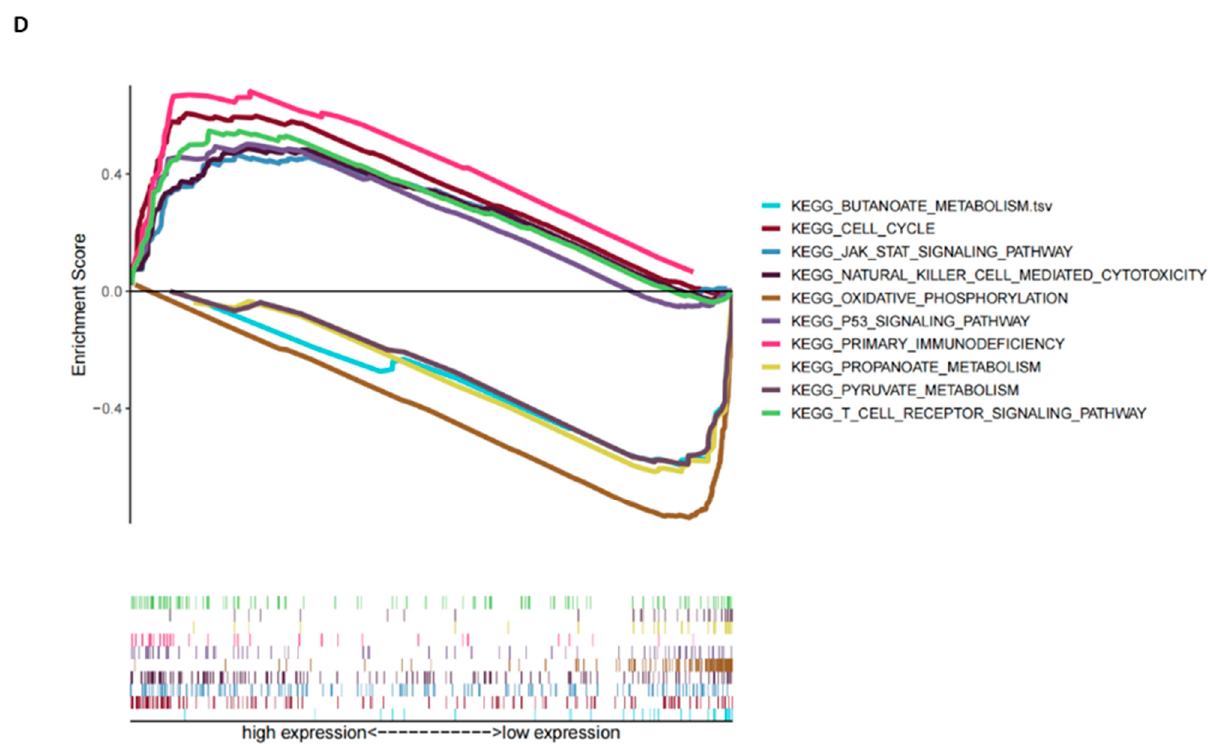
Figure 6. The correlation of the TIC composition and signaling pathway with EZH2 expression. ( A ) Correlation of the TIC population with EZH2 expression, the Violin diagram shows the relationship between the different 22 TIC subpopulations and the KIRC tumor samples with low (green) or high (red) EZH2 expression, relative to the median of the EZH2 expression level, the Wilcoxon rank sum was used for the significance test. ( B ) The scatter plot shows the correlation of 12 TIC subpopula- tions to the EZH2 expression ( p < 0.05), the blue line in each plot shows the fitted linear model indi- cating the proportion tropism of the immune cell along with the EZH2 expression, and the Pearson coefficient was used for the correlation test. ( C ) The Venn plot displays nine TIC subpopulations correlated with the EZH2 expression codetermined by difference and correlation tests displayed in violin and scatter plots, respectively. ( D ) The gene set enrichment analysis for the enriched gene sets with high and low EZH2 expression in the KEGG collection, each line represents one particular gene set with a unique color, upregulated gene sets are located on the left near at the origin of the coor- dinates, in contrast, the downregulated gene sets are on the right of the x-axis. Only gene sets with NOM p < 0.05 and FDR q < 0.06 were considered as significant and only some of the leading path- ways are displayed in the plot.